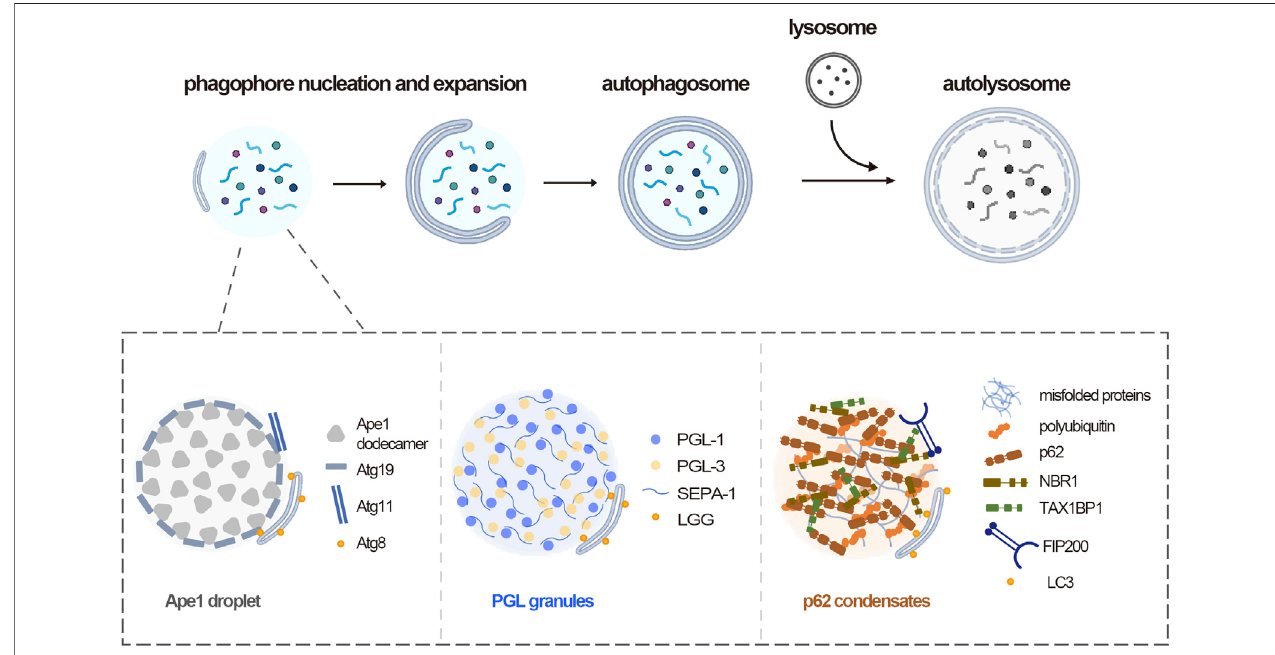
FIGURE 1 | Phase separation mediates autophagy substrates assembly. Upper panel, overview of autophagy process, including phagophore nucleation and expansion, autophagosome formation, fusion between autophagosome and lysosome. Lower panel, three representative autophagy substrates across species assemblethroughphaseseparation.Inyeast,Ape1dodecamersformdropletsbyphaseseparation,thenthereceptorAtg19isrecruited,whichinturnrecruitsAtg11.In C. elegans , PGL-1 and PGL-3 phase separated into gel-like condensates in somatic cells. In mammals, multivalent interactions between p62 and polyubiquitin drive p62 condensates formation. NBR-1 promotes p62 phase separation and recruits TAX1BP1, which cooperate for the FIP200 recruitment.